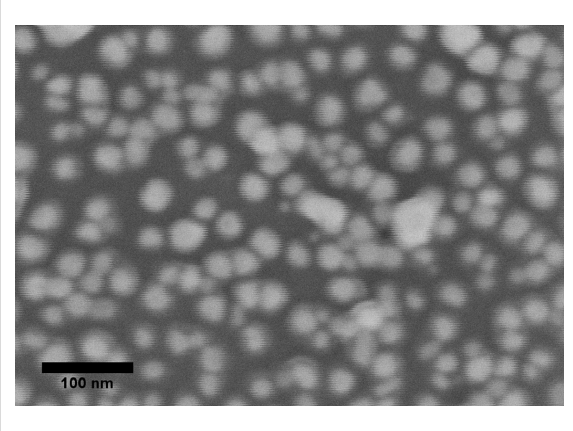
Figure 3: SEM image of Ag NPs immobilized on silicon surface by op- timized procedure. The surface coverage degree is